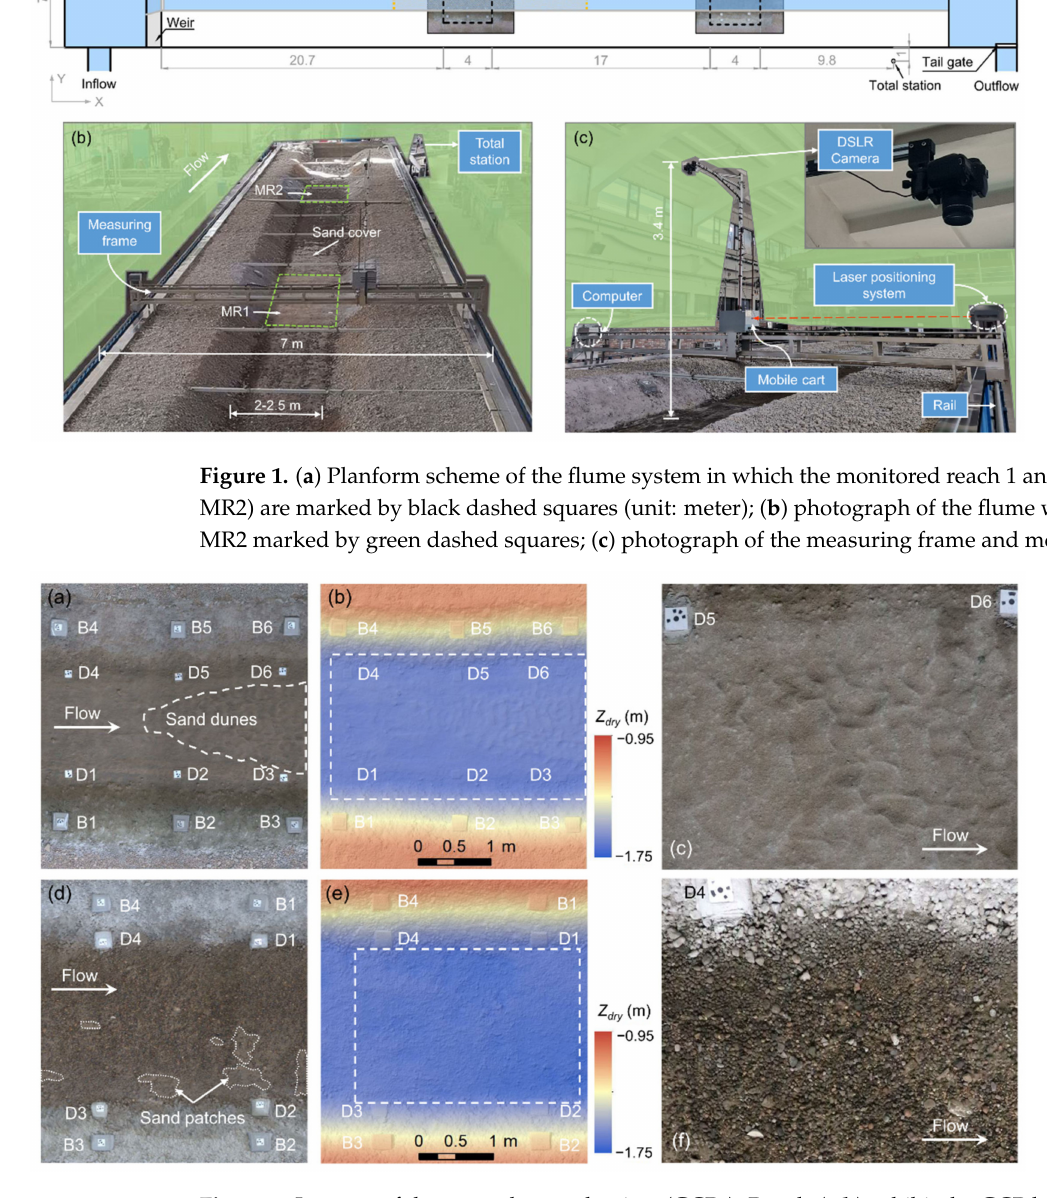
Figure 2. Layouts of the ground control points (GCPs). Panels ( a , b ) exhibit the GCP locations in the digital orthophotomosaic (DOM) and digital elevation model (DEM) of MR1, respectively, with the area of sand dunes marked in ( a ). Panel ( c ) presents a close photograph of the bed texture (with sand dunes) in MR1. Panels ( d , e ) show the GCP locations in the DOM and DEM of MR2, respectively, with the sand patches marked in ( d ), and panel ( f ) shows a photograph of the bed surface around D4 in MR2. The dashed squares in ( b , e ) depict the area analyzed in the results section, and Z dry indicates the bed elevations measured under dry bed conditions. All the GCPs shown in panels ( c , f ) had a side length of 10